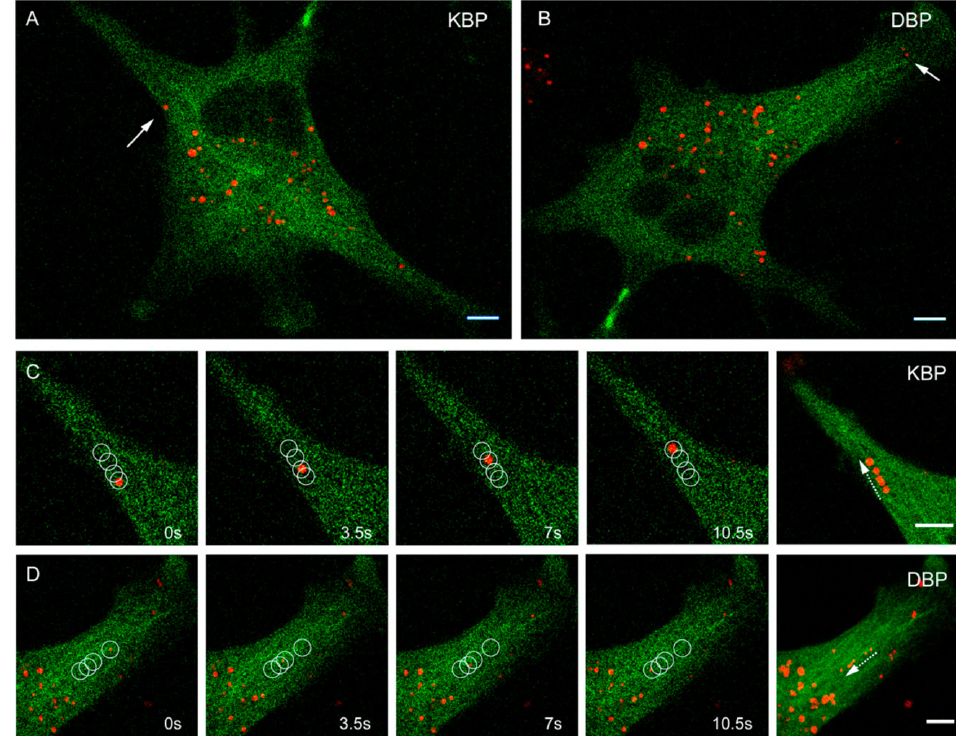
Figure 3. Representative confocal images of AHRTG cells incubated with 2.5 µ M KBP ( A ) or DBP ( B ), showing the microtubular network in green and the peptides probes designed as red dots. The white arrows indicate representative particles of each peptide that are further shown in panels (( C ); KBP) and (( D ); DBP). These panels show representative time-lapse images at times 0, 3.5, 7, and 10.5 s and superposition of these, of the movement of a KBP and a DBP particle, respectively. The resulting trajectories are indicated as white circles. Scale bar: 10 µ m. See also Videos S1 and